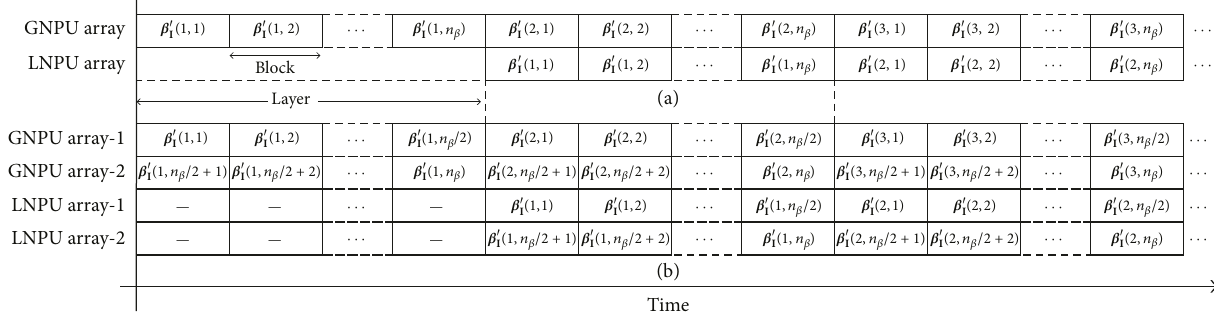
Figure 21: Pipeline timing diagram from the block processing perspective for (a) the 2 x version and (b) the 4 x version of the massively- parallel decoder architecture. Note that the ordering of 𝛽 󸀠 I (𝑢, 𝑤) blocks, ∀𝑢 ∈ {1,2, .. ., 𝐼} and ∀𝑤 ∈ {1,2,...,𝐽} shown here, is not unique, owing to the independence of the blocks as shown earlier. Here, 𝑛 𝛽 represents the number of columns of 𝛽 󸀠 I